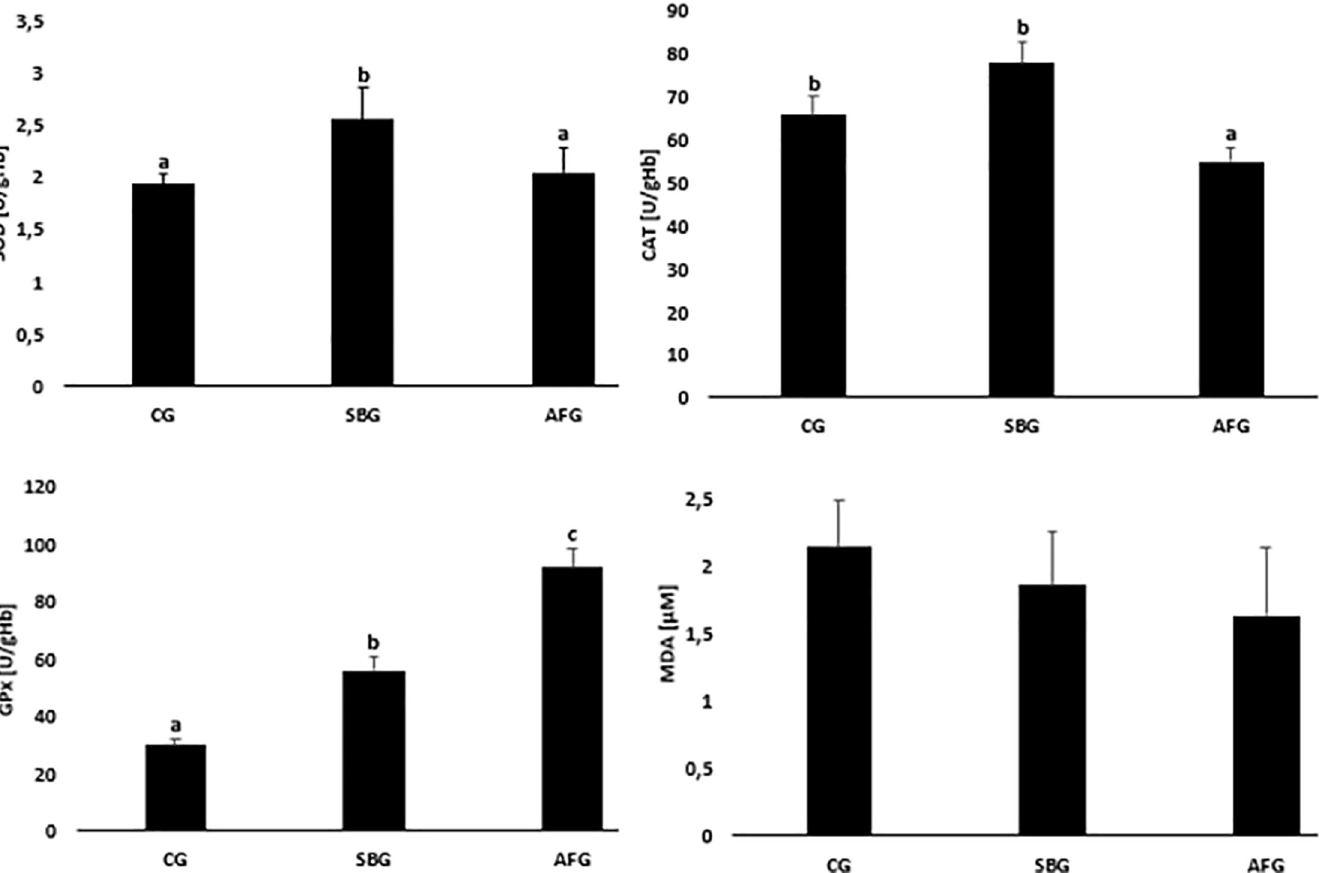
Fig 1. Effect of sucrose content diet and alternating feeding on erythrocyte superoxide dismutase (SOD), catalase (CAT), glutathione peroxidase (GPx) activities and plasma malonyldialdehyde (MDA) concentrations. CG—Control Group, SBG—Sucrose Balanced Group, AFG—Alternately Fed Group, a,b,c -Columns marked with different letters are statistically different, p �